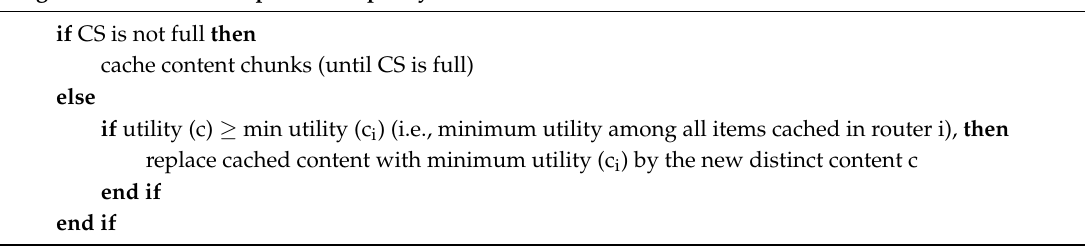
Algorithm 3. Content replacement policy of